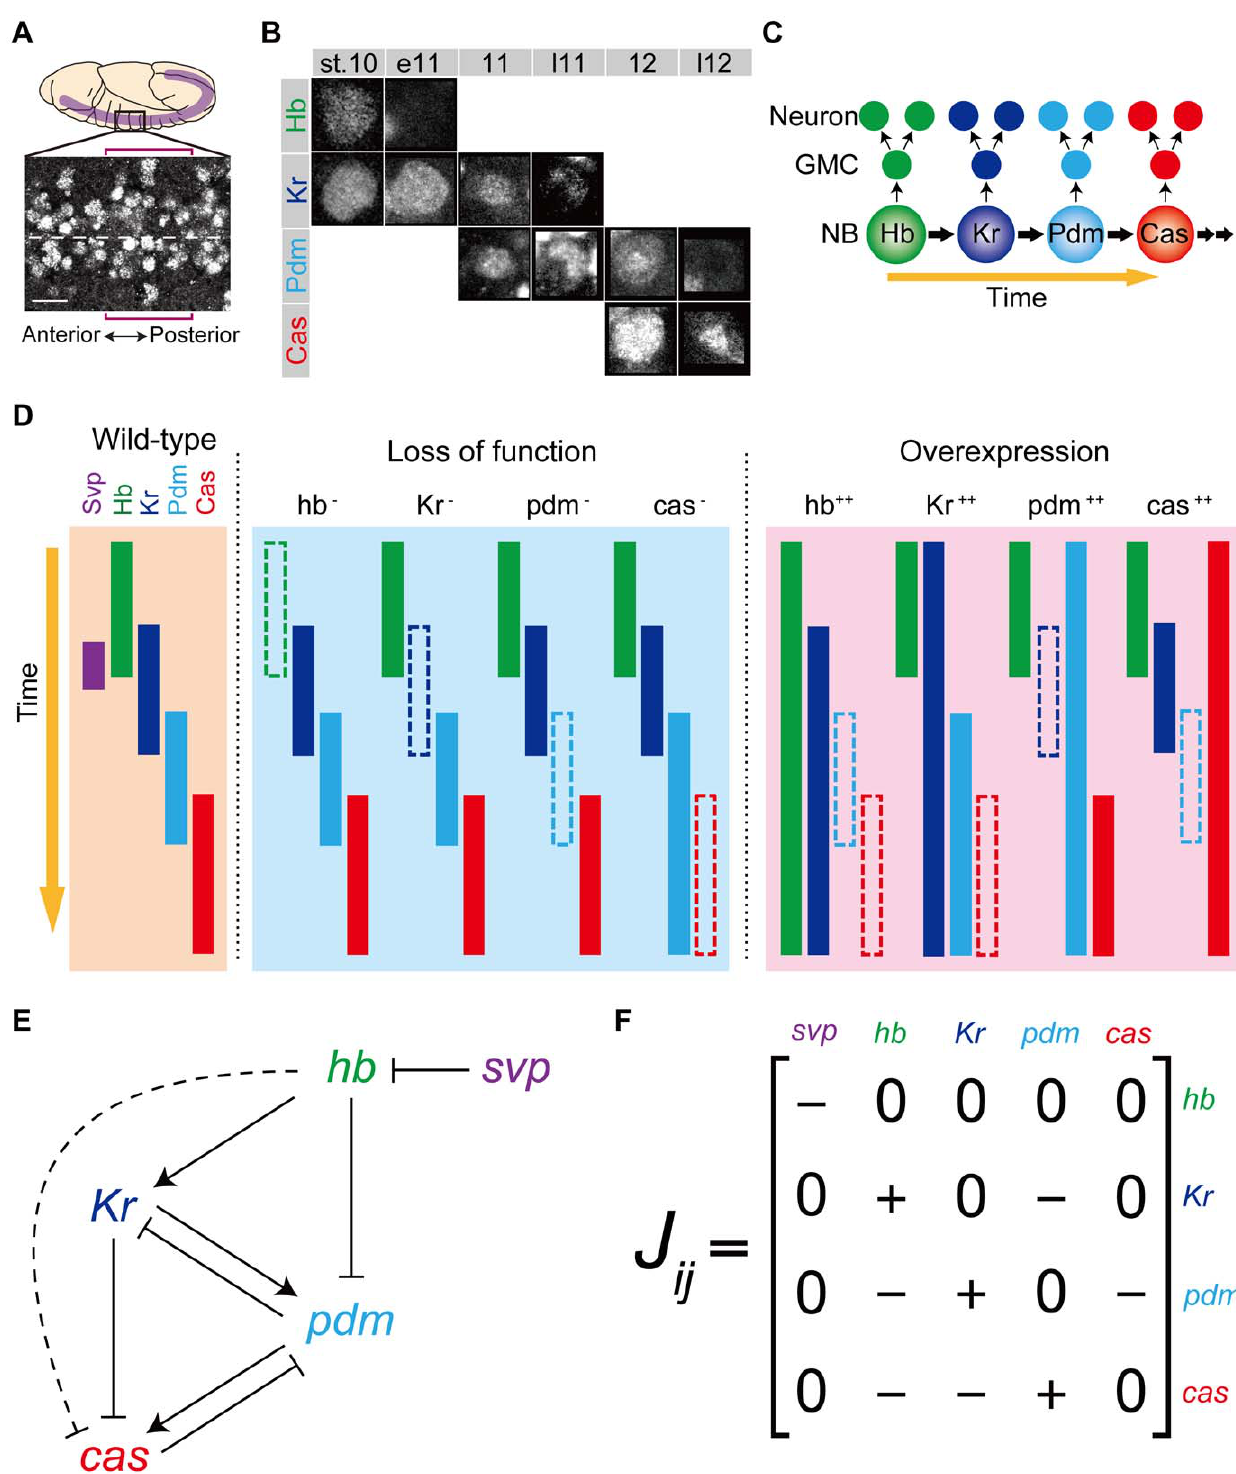
Figure 1. Sequential expression of temporal transcription factors within neuroblasts in the Drosophila CNS. ( A ) The relative position of neuroblasts (NBs) in Drosophila embryo. The picture is the ventral view of NBs and shows Cas expression in the NBs at developmental stage 12. The bracket indicates a single segment. Dashed line corresponds to the midline. Scale bar: 40 m m . ( B ) The expression levels of Hb, Kr, Pdm, and Cas in a single NB (NB 2–4 lineage) are shown from the developmental stage 10 to 12: early stage 10 (st. 10), early stage 11 (e11), mid stage 11 (11), late stage 11 (l11), mid stage 12 (12), late stage 12 (l12). ( C ) Schematic representation of the change of the expression pattern in a single NB. ( D ) The expression profiles of WT, loss-of-function, and overexpression mutants of the genes observed in the experiments (for references, see Table 2). ( E ) Reconstructed genetic network for sequential expression in Drosophila NBs. Repression from hb to cas (dashed line) was suggested to exist [26], although there is no direct verification. When the Drosophila network is invoked in this article, this regulation is also included. ( F ) Matrix representation of the Drosophila network.